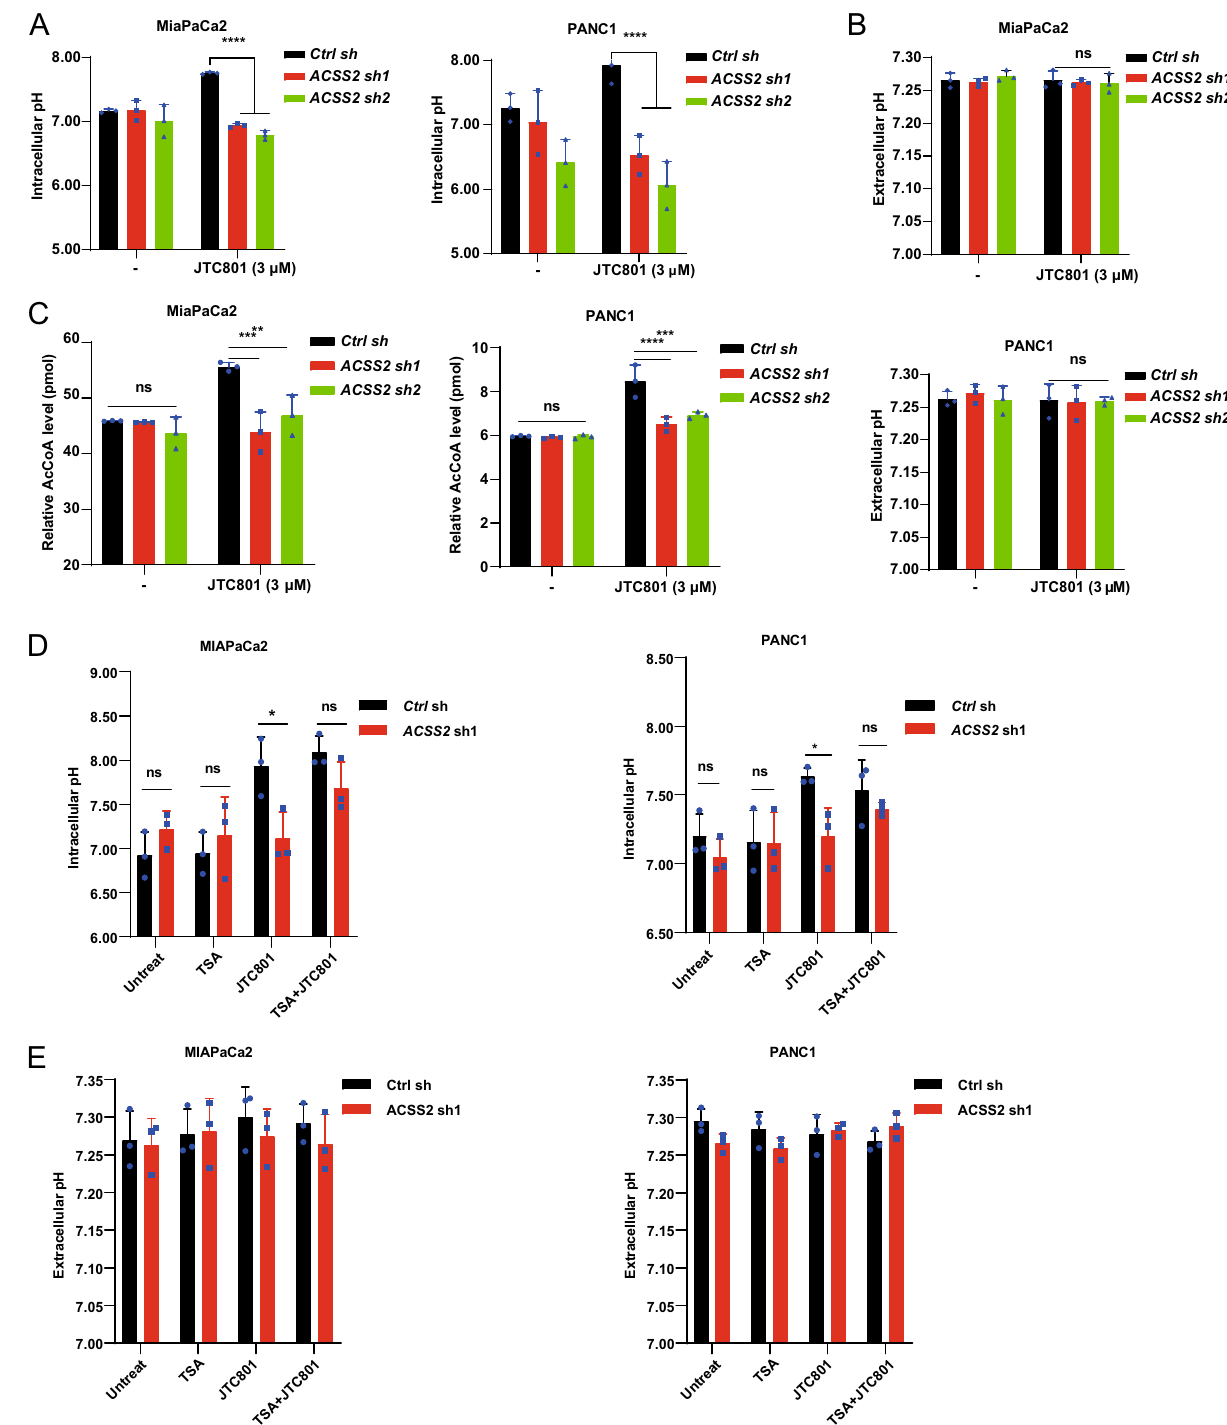
Figure 3. ACSS2-mediated histone acetylation inhibits cytoplasm acidification in alkaliptosis. ( A , B ) The intracellular and extracellular pH values were detected in indicated MiaPaCa2 and PANC1 cells after treatment with JTC801 (3 μM) for 24 h (n = 3 biologically independent samples). ( C ) ELISA analysis of acetyl-CoA levels in indicated MiaPaCa2 and PANC1 cells after treatment with JTC801 (3 μM) for 24 h (n = 3 biologically independent samples). ( D ) The intracellular pH values were detected in indicated MiaPaCa2 and PANC1 cells after treatment with JTC801 (3 μM) and trichostatin (TSA; 200 nM) for 24 h (n = 3 biologically independent samples). ( E ) The Extracellular pH values were detected in indicated MiaPaCa2 and PANC1 cells after treatment with JTC801 (3 μM) and trichostatin (TSA; 200 nM) for 24 h (n = 3 biologically independent